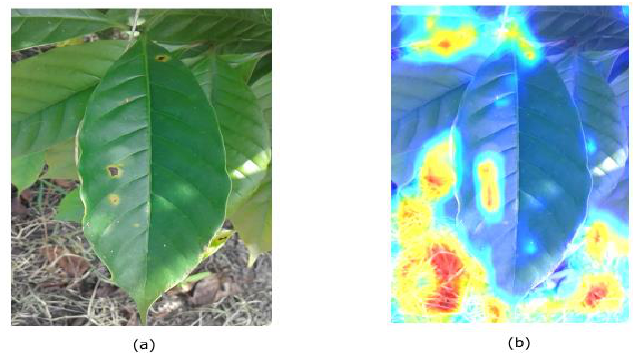
Figure 10. Visualization Result on naïve approach ( a ) input image; ( b ) highlighted image.